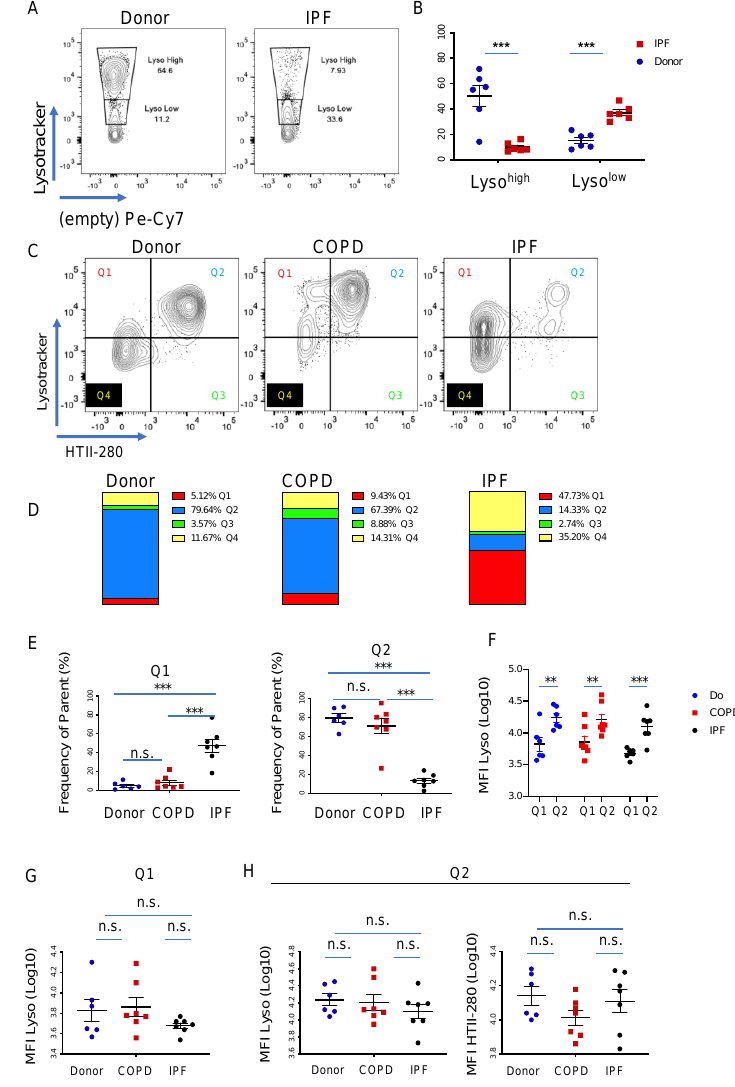
Figure 2. LysoTracker uptake in the epithelial compartment of the human lung. ( A ) Representative panels of flow cytometry analysis of the LysoTracker uptake (Lyso high and Lyso low ) in the epithelial compartment (DAPI − CD45 − CD31 − EpCAM + ) of human donor ( n = 6) and IPF ( n = 6) lungs. ( B ) Quantification of the Lyso high and Lyso low populations in donor and IPF samples in ( A ). ( C ) Representative panels of LysoTracker uptake ( y -axis) as a function of HTII-280 reactivity ( x -axis) in the epithelial compartment of donor ( n = 6), COPD ( n = 7) and IPF ( n = 7) lungs. Quadrant gating identifies four different populations as follows: Q1 (Lyso pos /HTII-280 neg ), Q2 (Lyso pos /HTII-280 pos ), Q3 (Lyso neg /HTII-280 pos ) and Q4 (Lyso neg /HTII-280 neg ). ( D ) Quantification of the data shown in ( C ) showing the relative contribution of the Q1 to Q4 populations to the epithelial compartment of donor, COPD and IPF lungs. ( E ) Quantification of Q1 (left diagram) and Q2 (right diagram) as the frequency of the parent (DAPI − CD45 − CD31 − EpCAM + ) population. ( F ) Comparison of the LysoTracker uptake in the LysoTracker-positive populations, Q1 and Q2, in donor, COPD and IPF patients, as measured by the MFI of the respective populations. ( G ) Comparison of the LysoTracker uptake in the Q1 population in donor, COPD and IPF patients, as measured by the MFI of the respective populations. ( H ) Comparison of the LysoTracker uptake (left panel) and HTII280 reactivity (right panel) in the Q2 population in donor, COPD and IPF patients, as measured by the MFI of the respective populations. Data are presented as the means ± SEM of the percentage of cells from the parent population. Statistical analysis was performed on log(10) values. ** p < 0.01, *** p < 0.001, n.s. = not significant by